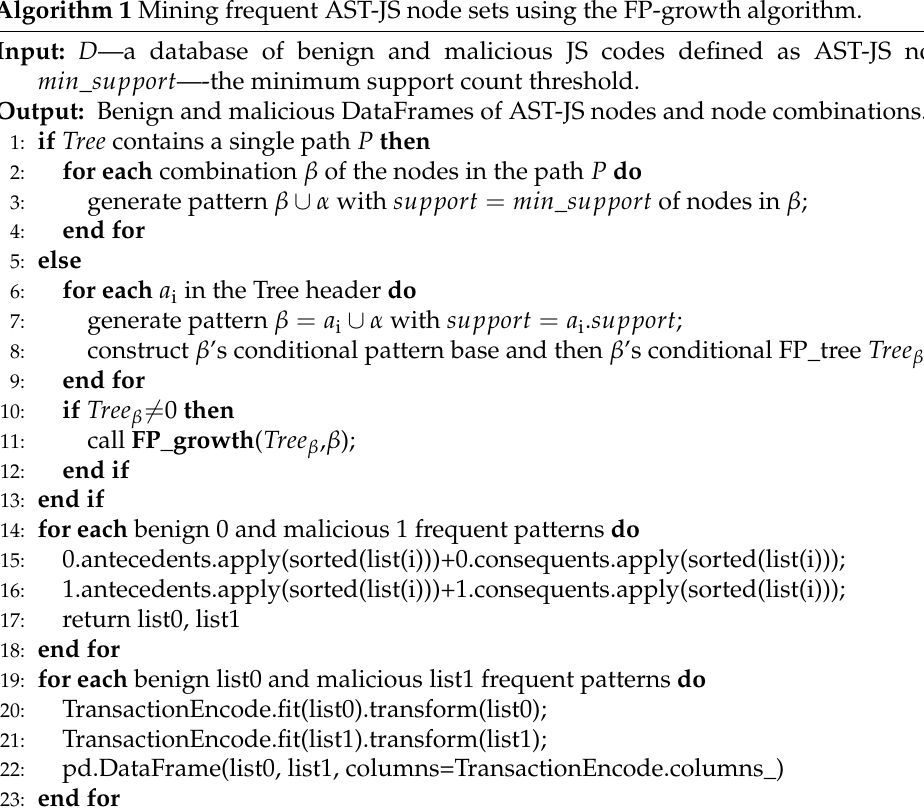
Algorithm 1 shows AST-JS’s association rule mining procedure using the FP-growth algorithm. The generated association rules for benign and malicious JS codes are trans- formed into a list (lines 14–17). For AST-JS feature selection, the lists are converted into individual benign and malicious data frames (lines 19–22). Algorithm 1 Mining frequent AST-JS node sets using the FP-growth